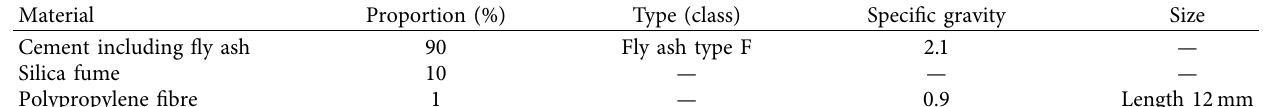
Table 2: Physical properties of the materials and mix design proportion for SPC.